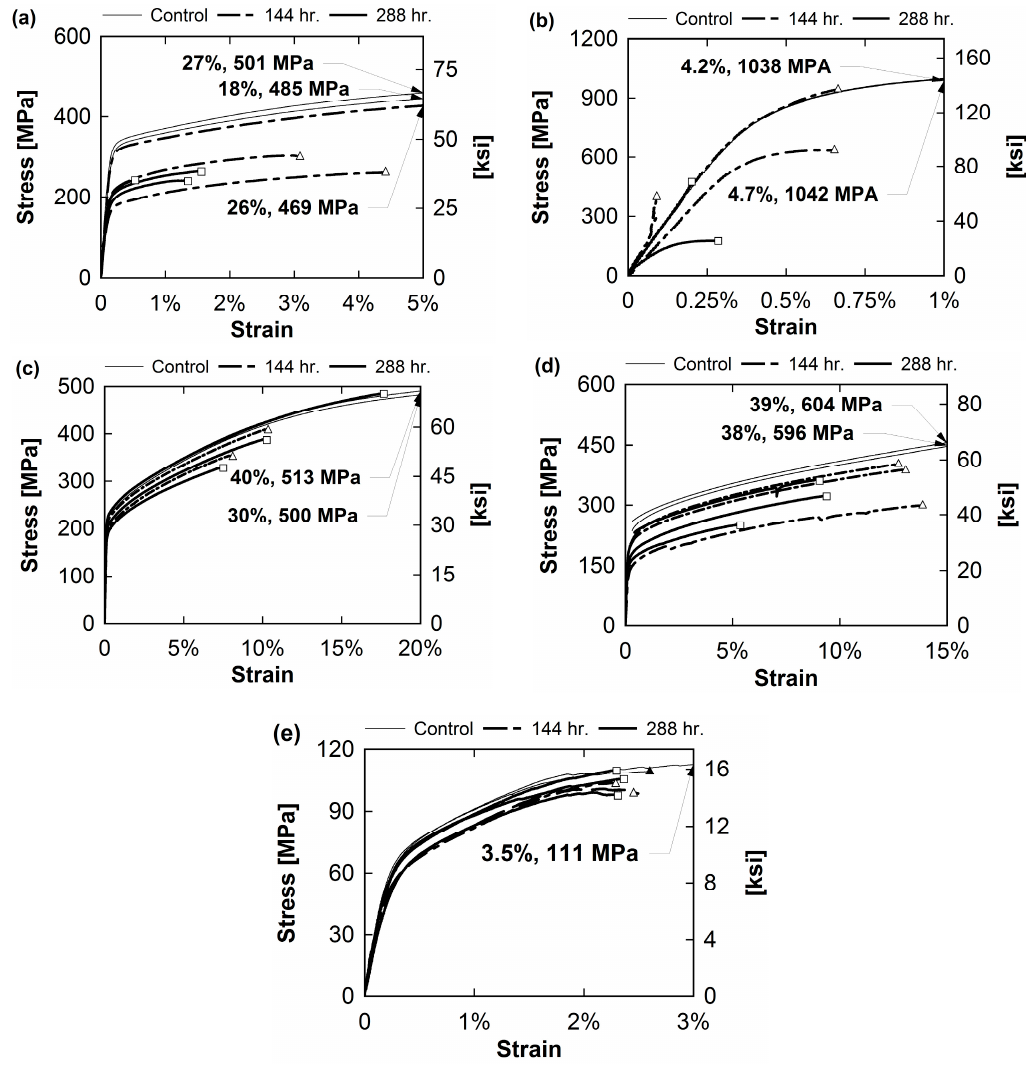
Figure 7. Stress–strain curves for stainless steel ( a ) Type 430, ( b ) Type 17 ‐ 4, ( c ) Type 316, ( d ) Type